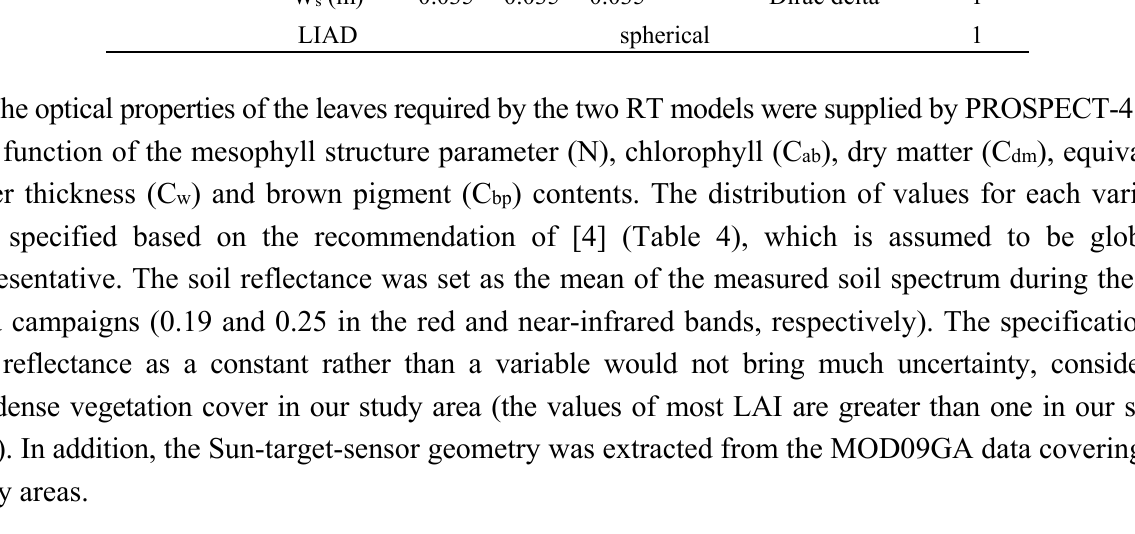
Table 4. Distribution of the input variables of the PROSPECT-4 model used to generate leaf reflectance and